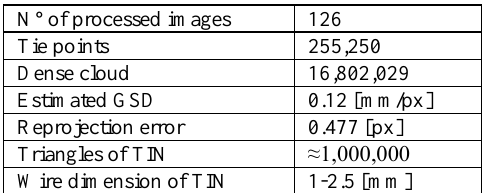
Figure 8. Photogrammetric dense point cloud